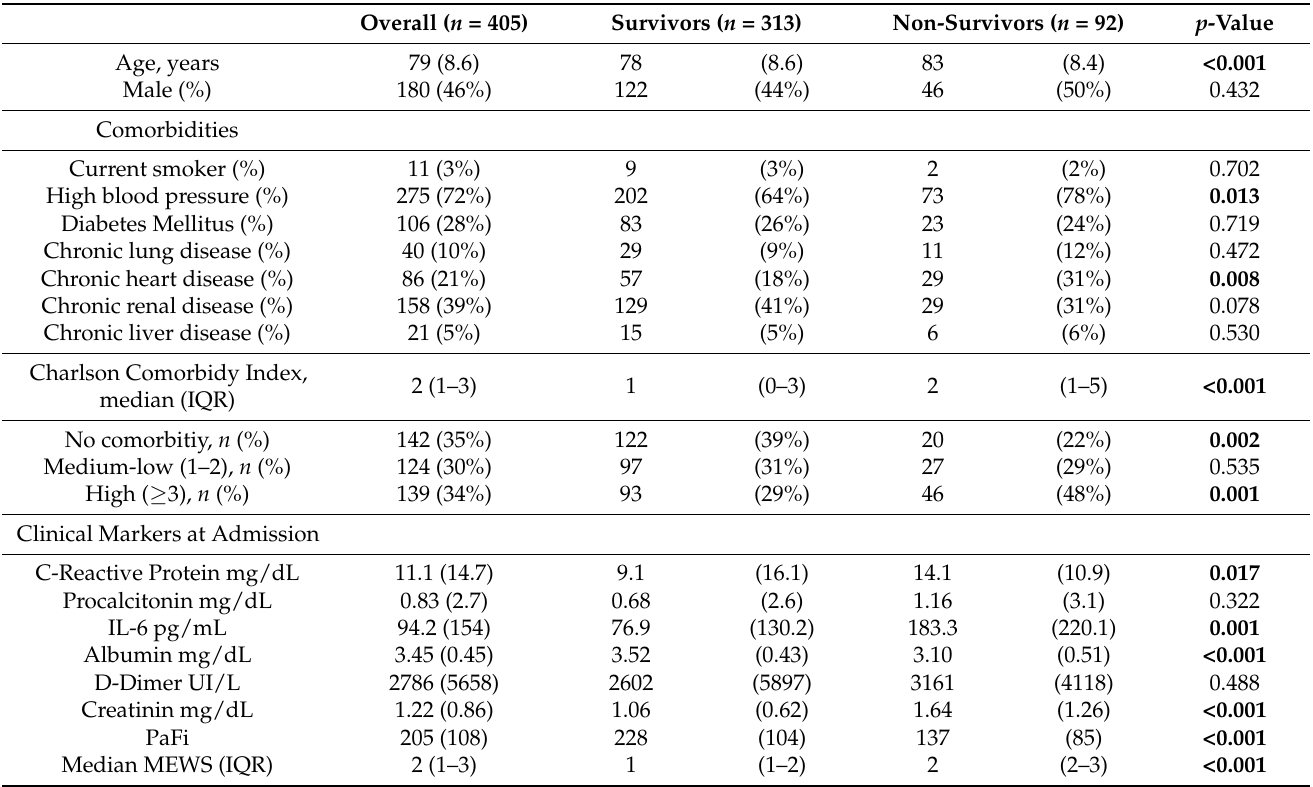
Table 1. Baseline characteristics among older adults with SARS-CoV-2 infection stratified according to in-hospital mortality.